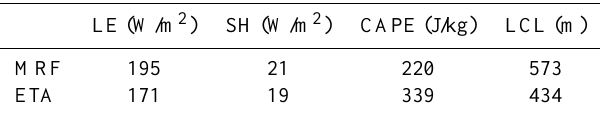
Table 3. Average values of the surface fluxes and cloud variables calculated by the numerical model for 14 September 1999. The CAPE is calculated up to a level of